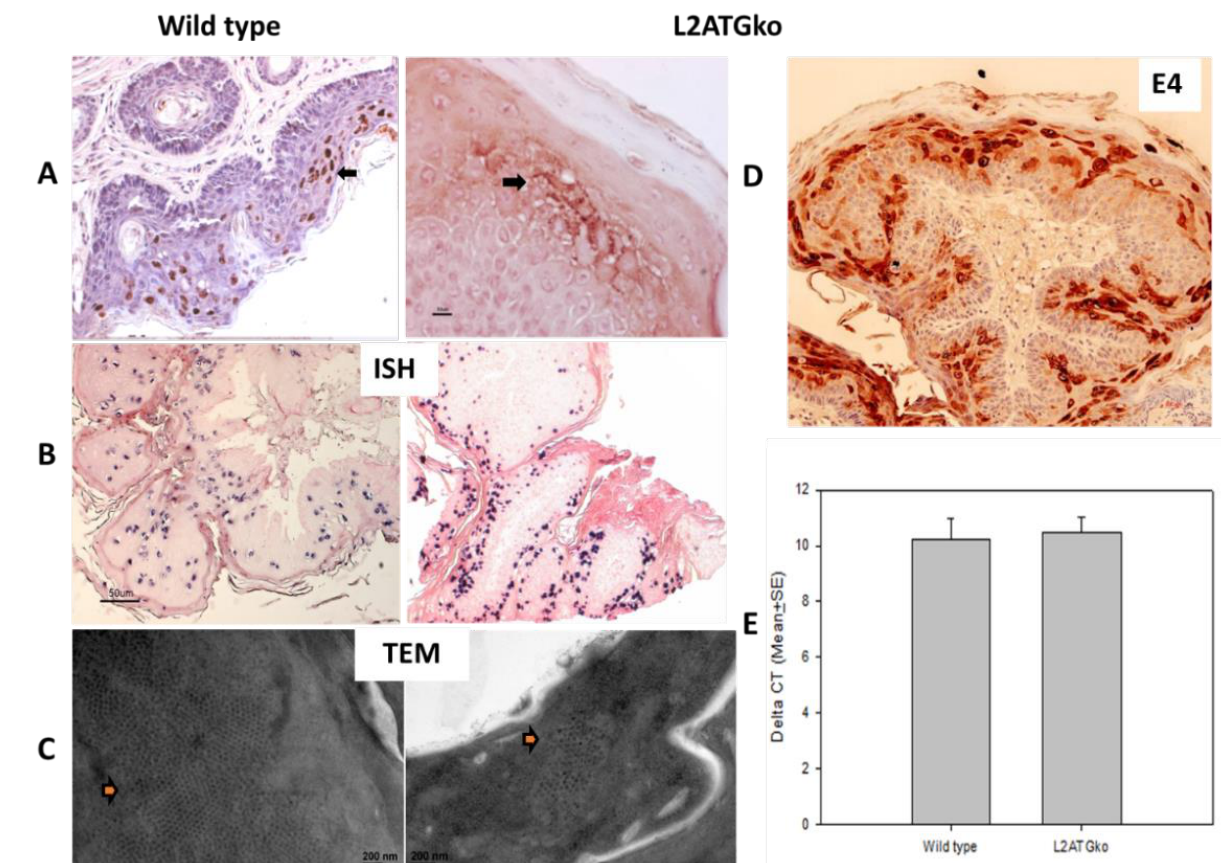
Figure 4 . L2 is not required for L1 expression but influences L1 location. L1 expression in L2ATGko mutant lesions was mild–moderate and predominately present in the cytoplasm, while the wild-type lesions demonstrated moderate nuclear expression ( A , 20×) although a comparative amount of viral DNA was detected ( B , 10×). In addition, one of the two tail lesions exhibited viral particles by EM (arrows), although detection required exhaustive searching; wild-type lesions contained far more abundant viral particles ( C ). The cytoplasm of suprabasal epidermal cells was strongly positive for viral E4 protein in the L2ATGko mutant-induced lesions ( D ). Biopsies were harvested from lesions induced by the L2ATGko mutant or wild-type MmuPV1 for DNA extraction. No significant difference was found in the DNA copy number from the wild-type lesions and L2ATGko lesions ( E , p > 0.05, unpaired Student’s t -test).